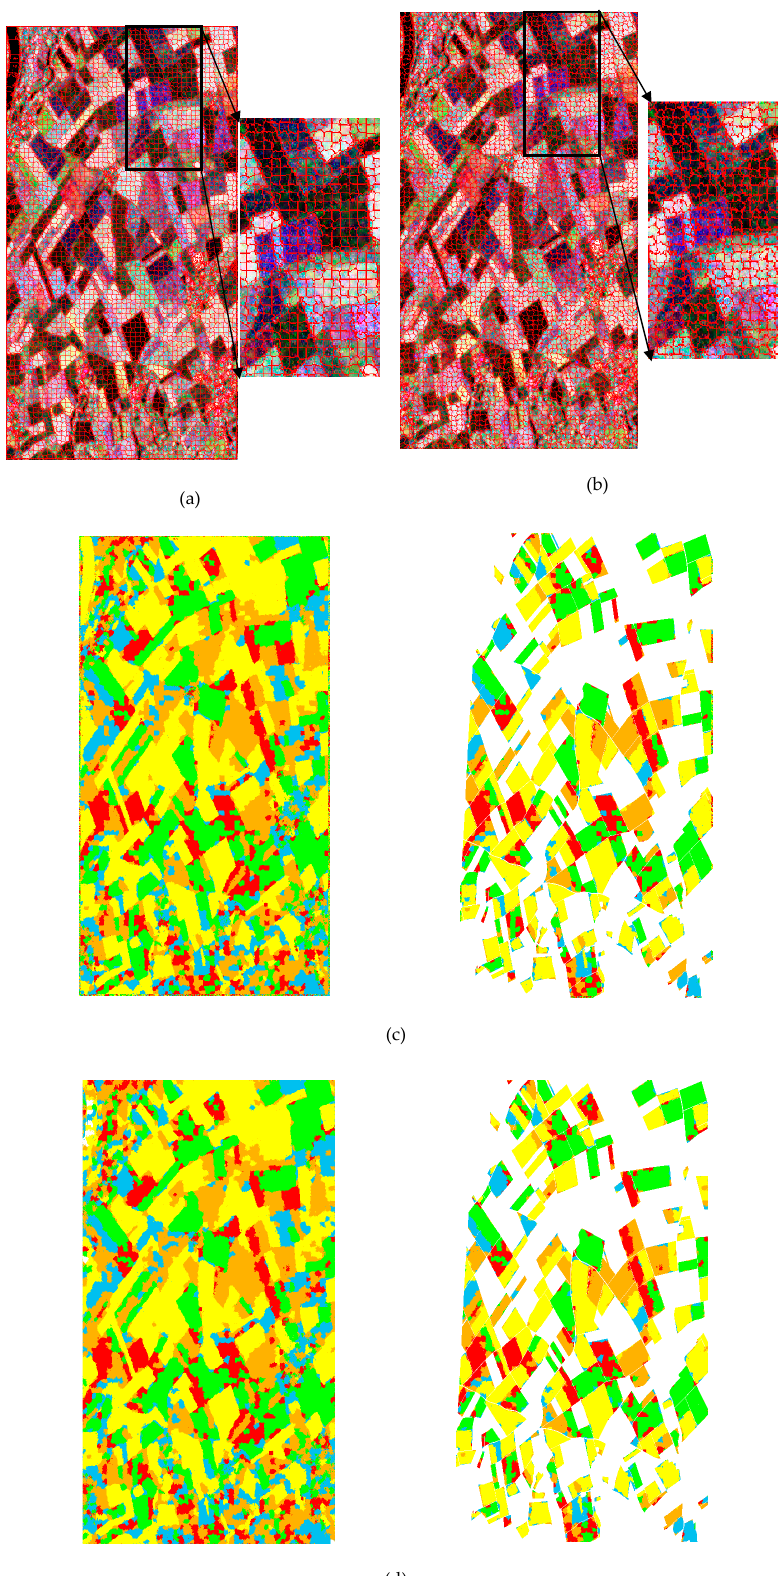
Figure 8. Region-based segmentation and classification results of the Flevoland area. ( a )-( b ) Segmentation results of the whole image. ( a ) WMRF. ( b ) KMRF. ( c ) Classification result with WMRF. ( d ) Classification result with KMRF.